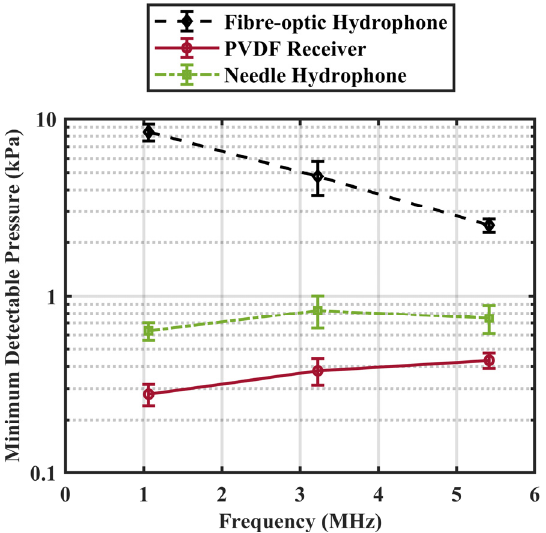
Figure 5. Minimum detectable pressure (kPa) as measured by a commercial fibre-optic hydrophone (Fibre optic 17 – 25, Precision Acoustics, United Kingdom), a needle hydrophone (HP series, Precision Acoustics, United Kingdom), and the PVDF receiver. Error bar indicates one standard deviation.